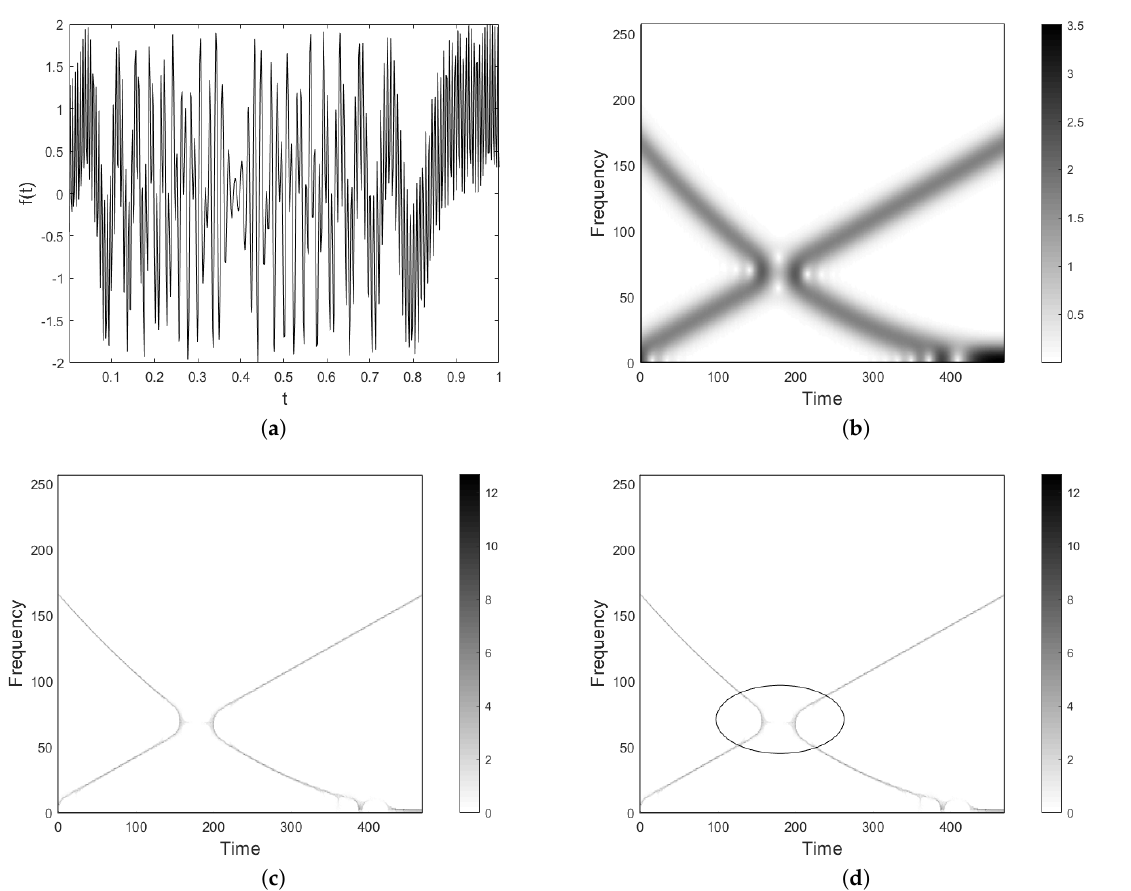
Figure 2. ( a ) Two-component signal whose IFs do not satisfy the separability condition; ( b ) Signal spectrogram; ( c ) Reassigned spectrogram; ( d ) Interference